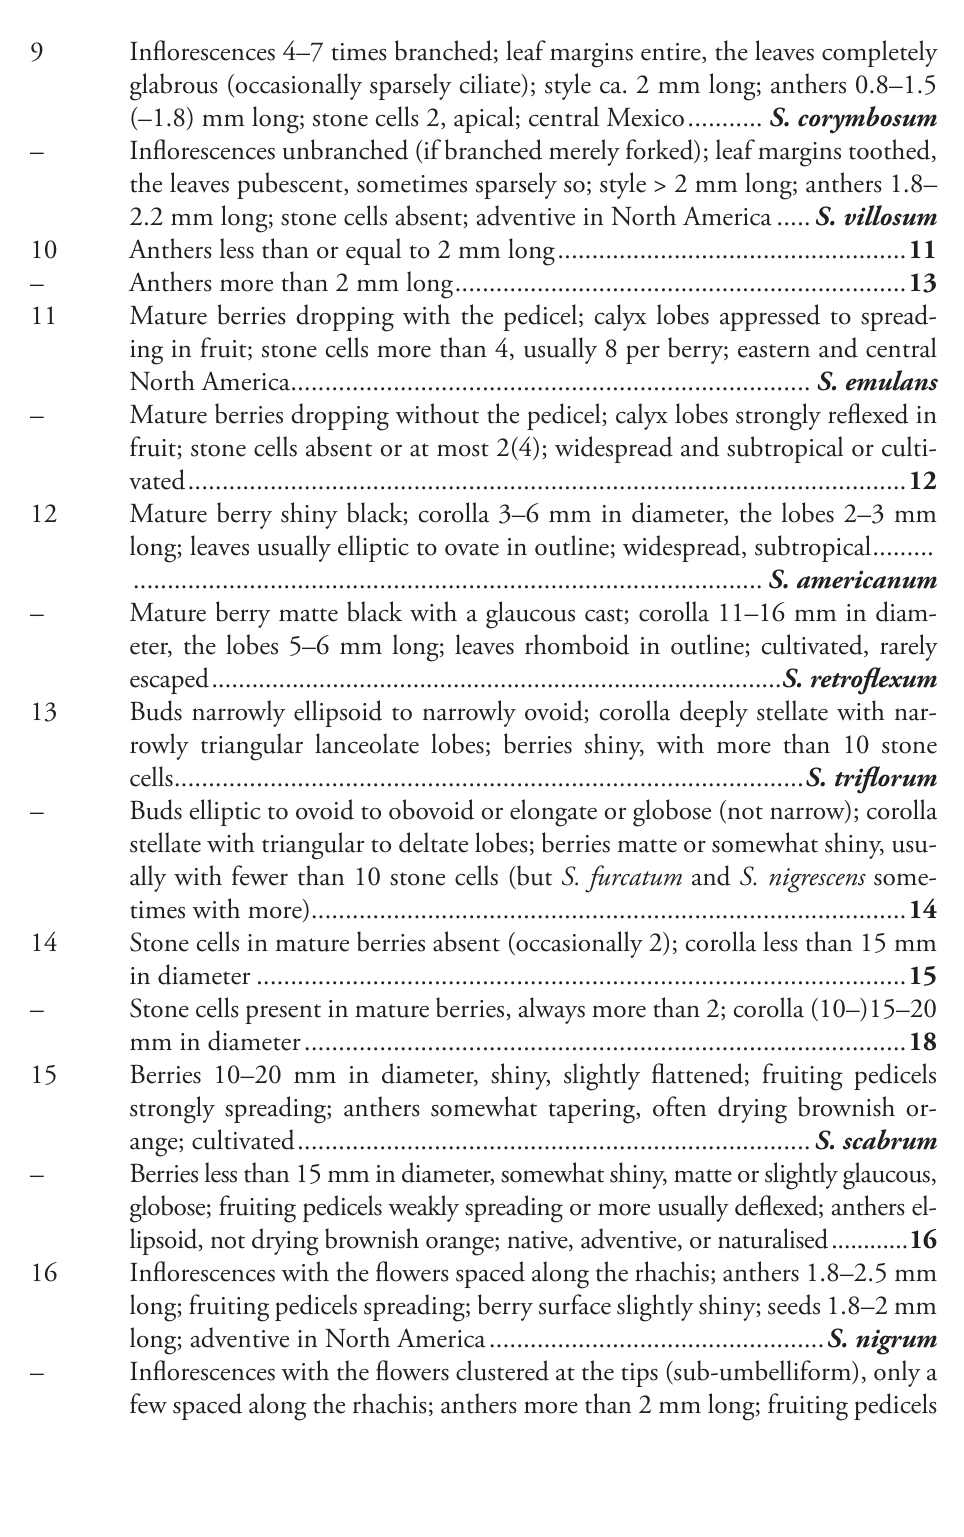
Inflorescences 4–7 times branched; leaf margins entire, the leaves completely glabrous (occasionally sparsely ciliate); style ca. 2 mm long; anthers 0.8–1.5